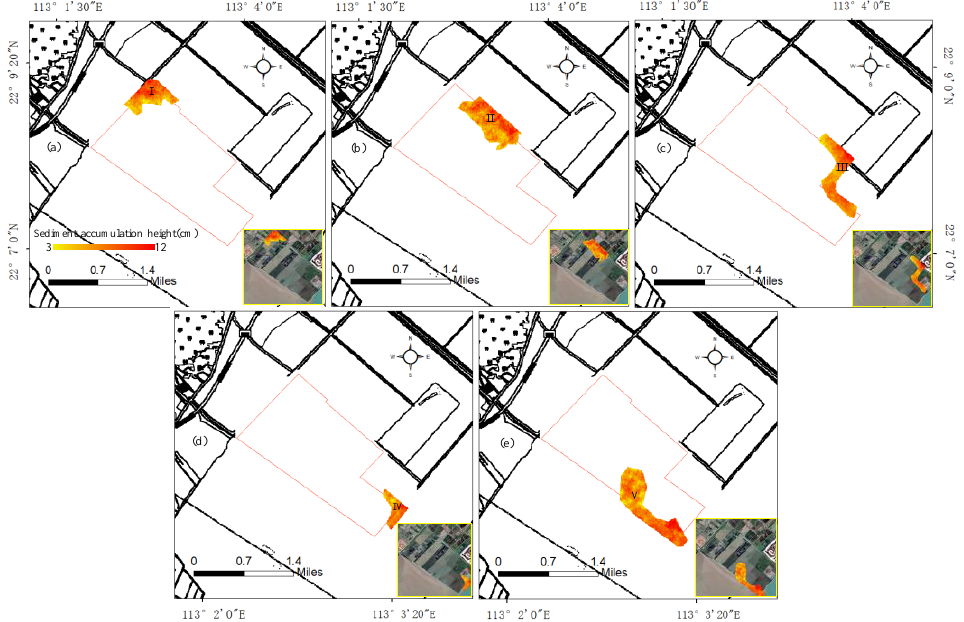
Figure 8. ( a – e ) plots show several areas of sediment accumulation observed by D-InSAR and sand flows in mud reception zones during monitoring.